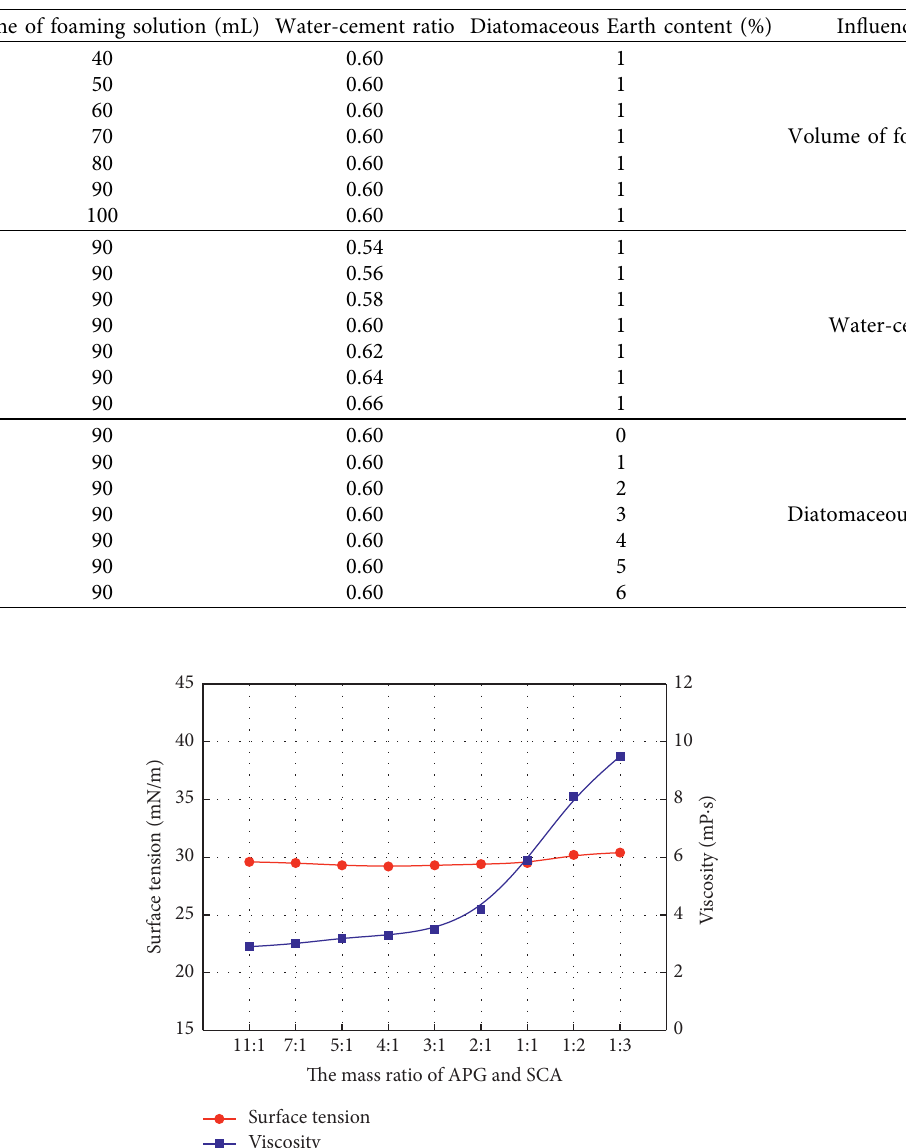
Figure 1: The preparation process of foamed concrete. Table 3: Orthogonal test scheme.